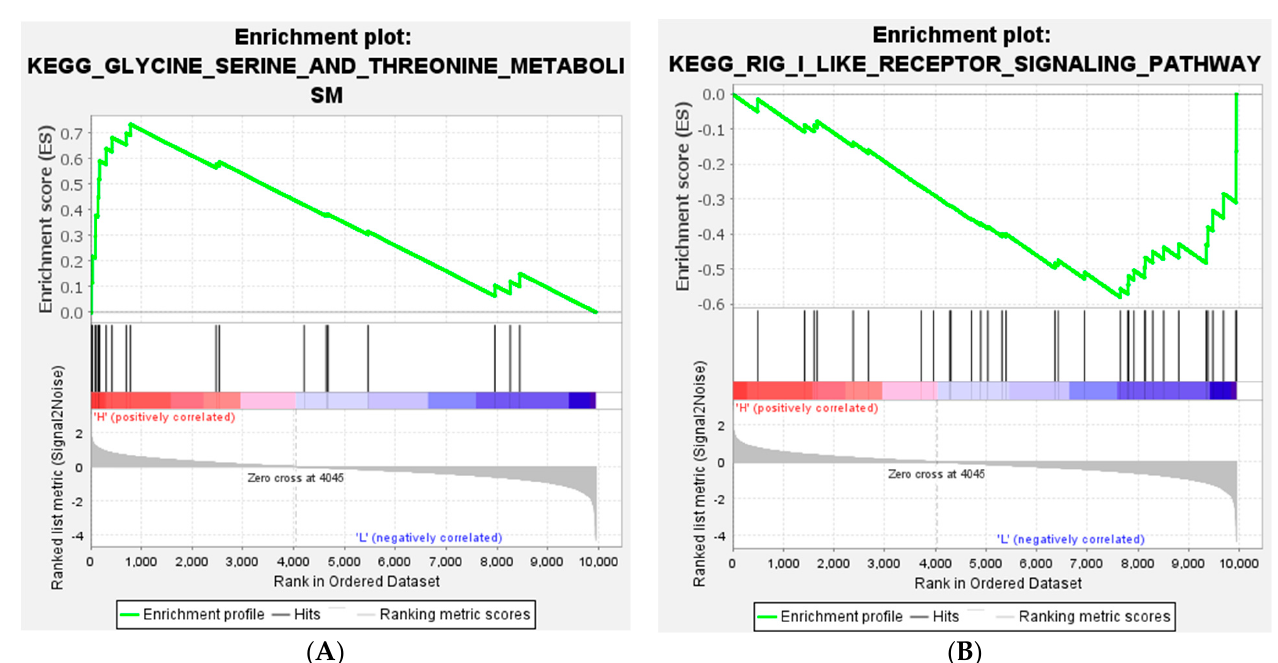
Figure 7. Gene set enrichment analysis (GSEA). The enrichment plot of most significant expressed in ( A ) HFE (glycine, serine, and threonine metabolism) and ( B ) LFE (RIG-I-like receptor signaling pathway) birds. Table 6. List of all gene sets with an FDR ≤ 0.25.